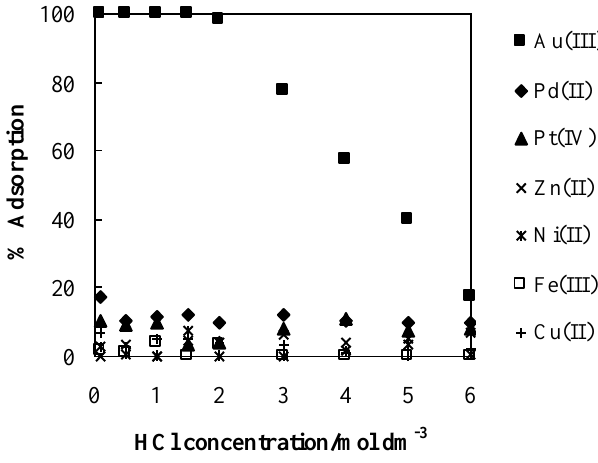
Figure 18. Percentage adsorption of various metal ions on CPT gel as a function of concentration of hydrochloric acid [33] (with permission for reuse from Elsevier B.V.).